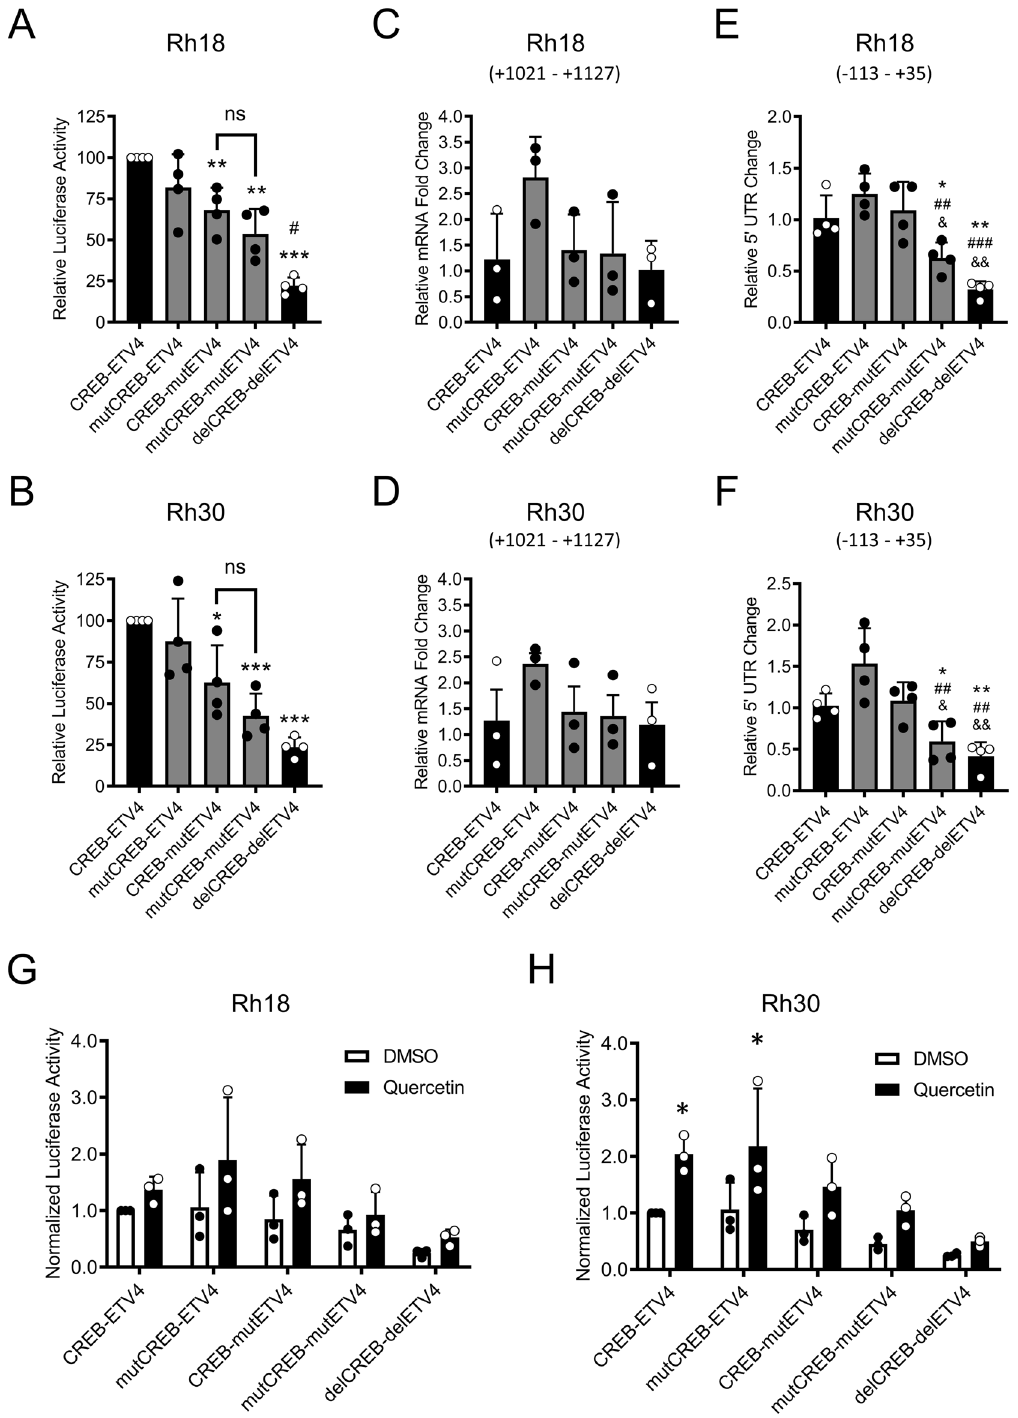
Fig. 5 CREB and ETV4 consensus sites in the PANX1 promoter regulate PANX1 expression in RMS cells. Rh18 (eRMS) and Rh30 (aRMS) cells were co-transfected with pRL-TK and pGL3 vectors containing one of the following constructs: the wildtype PANX1 promoter (CREB-ETV4) or the PANX1 promoter with point mutations in CREB (mutCREB-ETV4), ETV4 (CREB-mutETV4), or both sites (mutCREB-mutETV4). The pGL3 vector containing PANX1 promoter with dual site deletion (delCREB-delETV4) was also included as a negative control. After 48 h, cells were analyzed by dual-luciferase reporter assays ( n = 4) ( A , B ) and then with RT-qPCR ( n = 3) for FF (ampli fi ed at + 1021 to + 1127 from FF ATG start codon) ( C , D ) or PANX1 5 ′ UTR (ampli fi ed at − 113 to + 35 from PANX1 ATG start codon) ( E , F ) ( n = 4). Dual-luciferase reporter assays ( n = 3) were also performed in cells 48h post-co-transfection following 24-h DMSO or quercetin treatment prior to analysis ( G , H ). One-way ANOVA with Tukey ’ s post-hoc test was performed in ( A – F ). In ( A ) and ( B ), * P <0.05, ** P < 0.01 and *** P < 0.001 compared to CREB-ETV4; # P <0.05 compared to mutCREB-mutEVT4; ns = not signi fi cant. In ( E ) and ( F ), * P <0.05 and ** P <0.01 compared to CREB-ETV4; ## P < 0.01 and ### P < 0.001 compared to mutCREB-ETV4; & P <0.05 and && P <0.01 compared to CREB-mutETV4. Multiple Student ’ s t tests with Holm – Sidak correction for multiple comparisons were performed in ( G , H ). In ( H ), * P <0.05 compared to DMSO. pRL-TK was used as an internal normalizer in all results shown. Results are expressed as mean ± s.d. ( n = 3 or